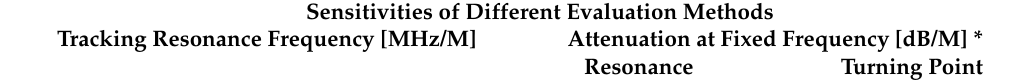
Table 1. Sensitivities of aspartic acid, glycine, lysine, and threonine measured with the vector network analyzer (tracking the resonance frequency shift vs. recording the attenuation at two different fixed measuring frequencies, the resonance frequency and the left turning point of the frequency response for UHPLC-MS grade water). * M is defined as mol/L, dB is measured at a power of 0 dBm, and thus the power is referenced to 1 mW.